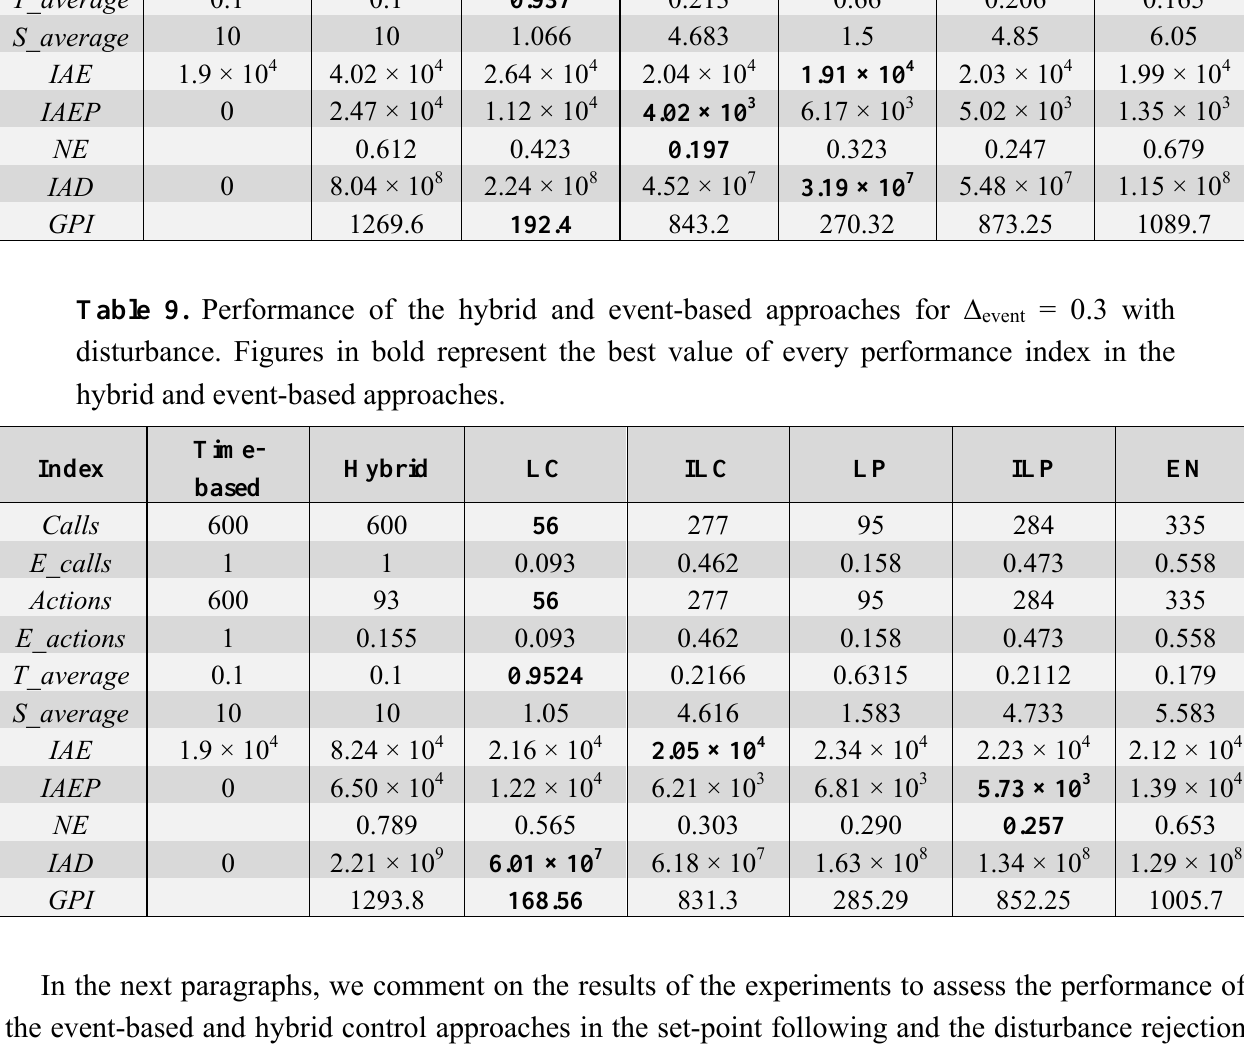
Table 8. Performance of the hybrid and event-based approaches for  disturbance. Figures in bold represent the best value of every performance index in the hybrid and event-based approaches.